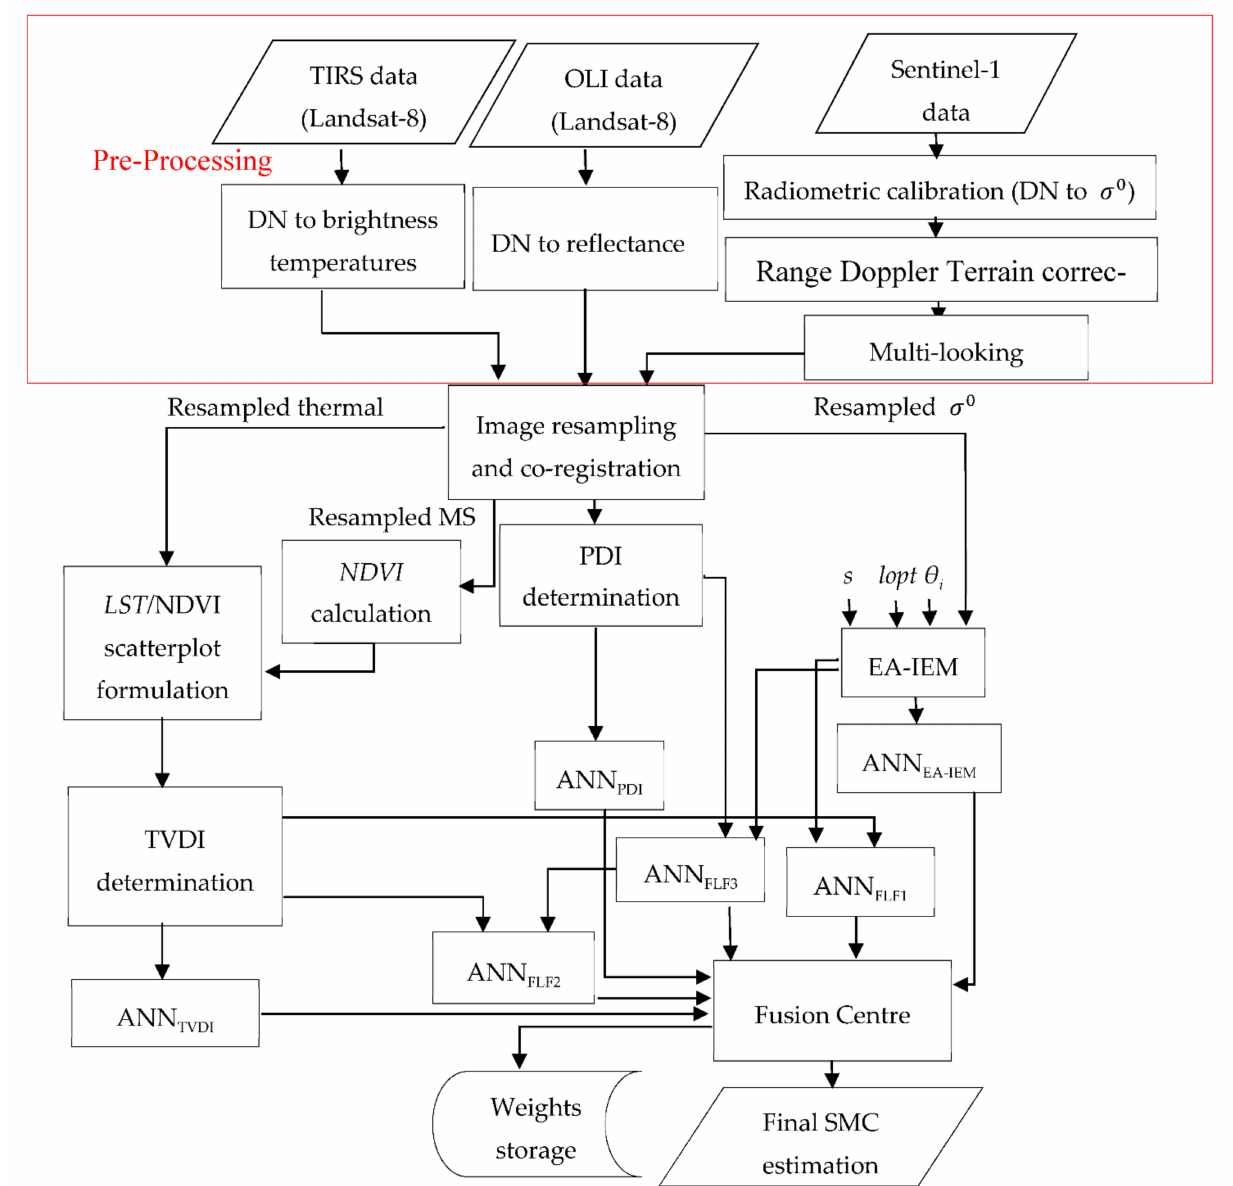
Figure 4. The proposed soil moisture content estimation